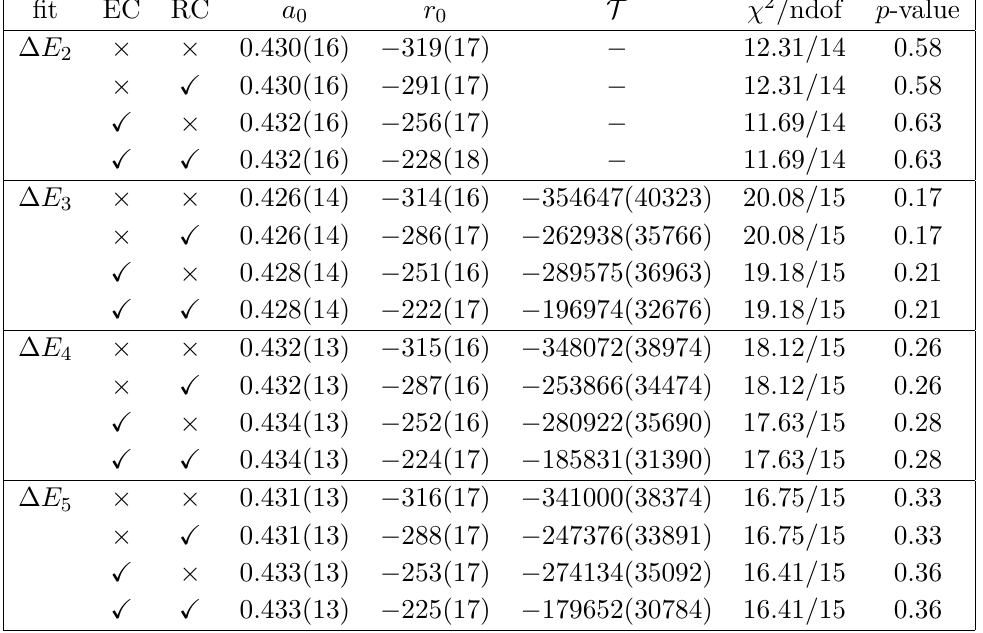
Table 5. The results, obtained from the fixed- N energy shift fits at order L − 6 in the interval [9 , 24] with and without EC and RC. The results for a 0 and r 0 obtained from the ∆ E 2 -fit serve as priors in the remaining